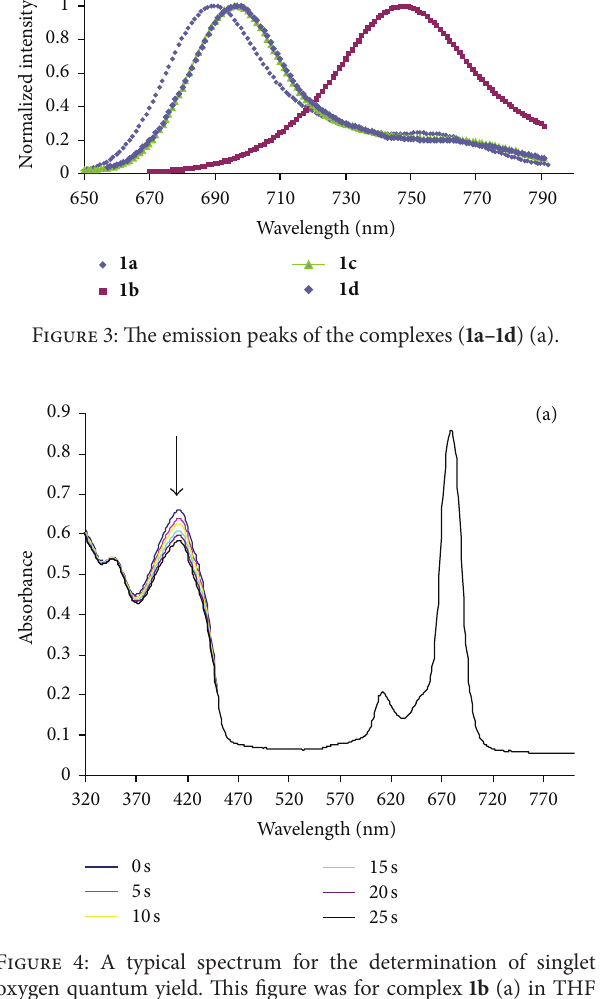
Figure 6: Fluorescence emission spectral changes of 1d (a) (1.00 × 10 −5 mol dm −3 ) on addition of different concentrations of BQ in THF. [BQ] = 0, 0.008, 0.016, 0.024, 0.032, and 0.040 mol dm −3 and saturated with